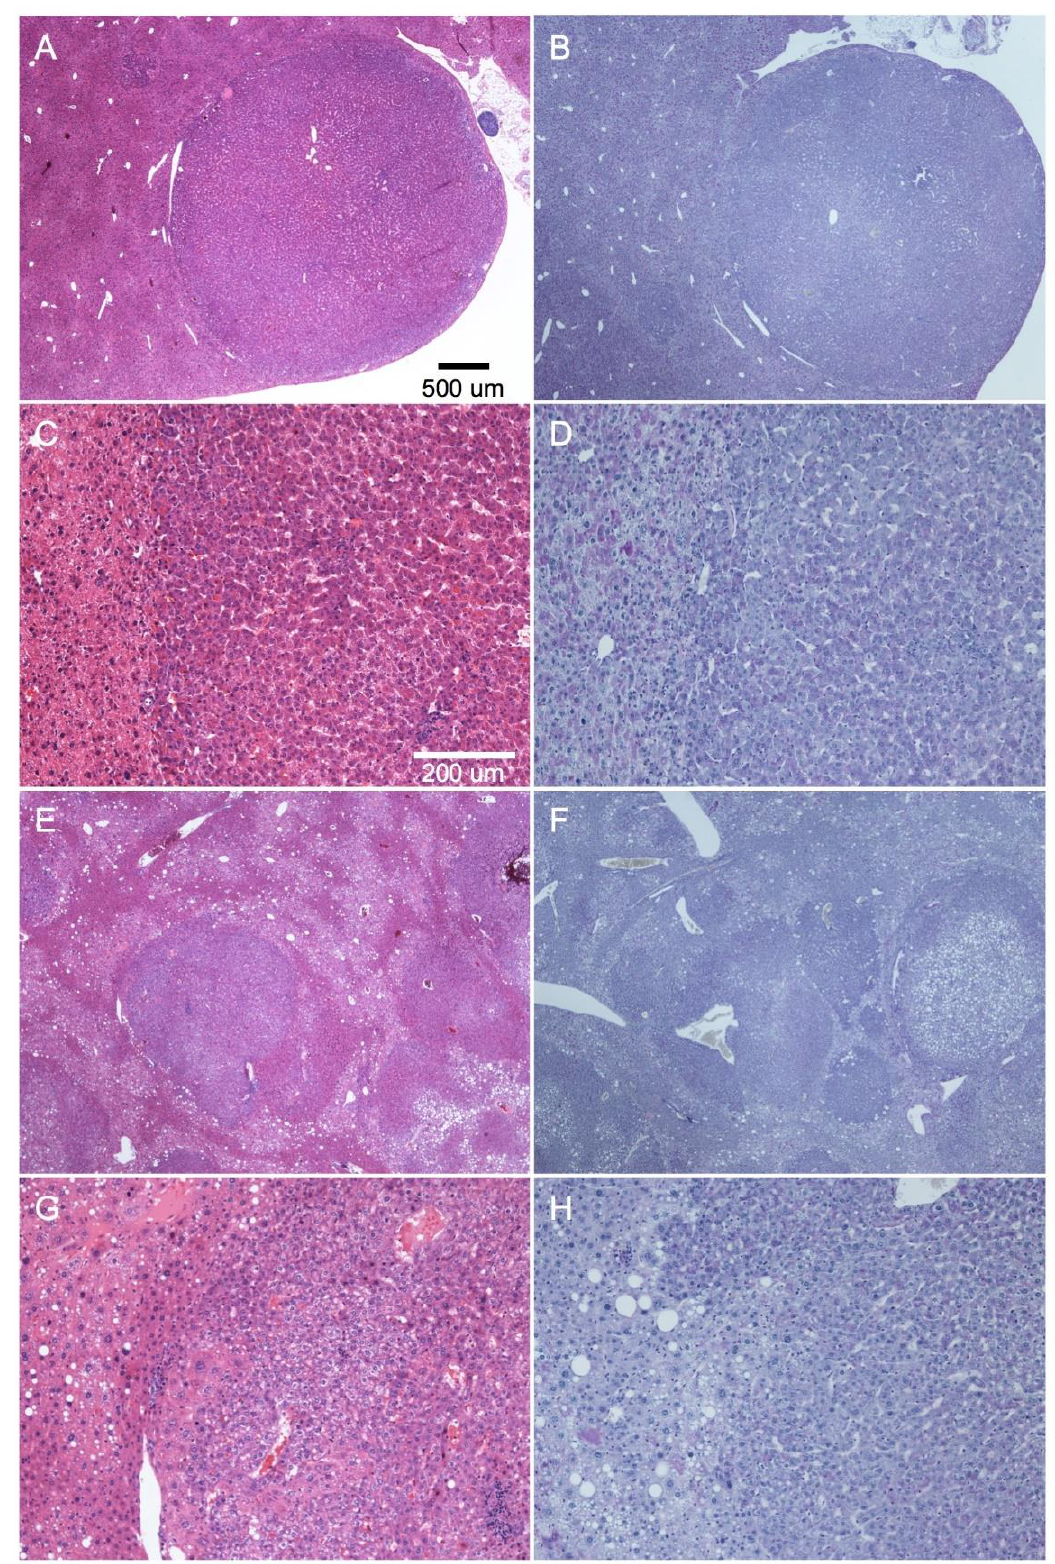
Figure 5. Histochemistry of diethylnitrosamine (DEN)-induced hepatocellular carcinomas of wild-type ( A – D ) and Usp28 knock-out ( E – H ) mice. H/E stain ( A , C , E , G ) and PAS reaction ( B , D , F , H ). Representative images are shown. ( A , B ) and ( E , F ) are overviews of ( C , D ) and ( G , H ) respectively. The scale bars in ( A ) and ( C ) are applicable to ( B , E , F ) and ( D , G , H ), respectively.